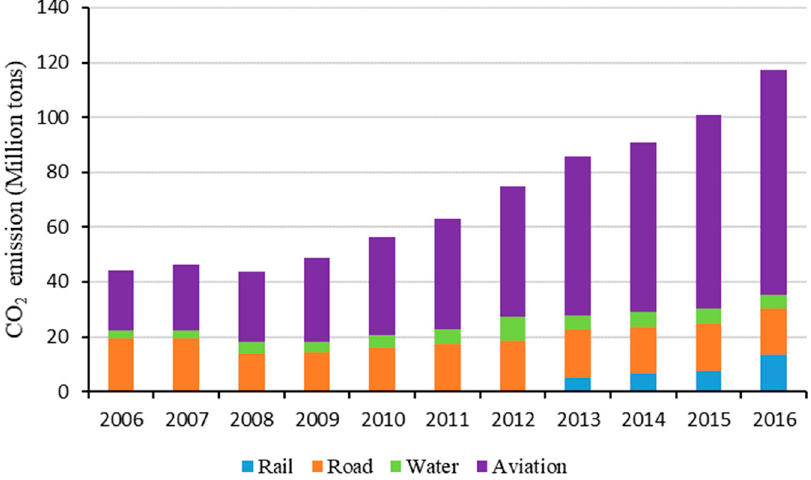
Figure 6. The modal structure of CO 2 emissions from transportation of the Pearl River Delta, 2006 – 2016.